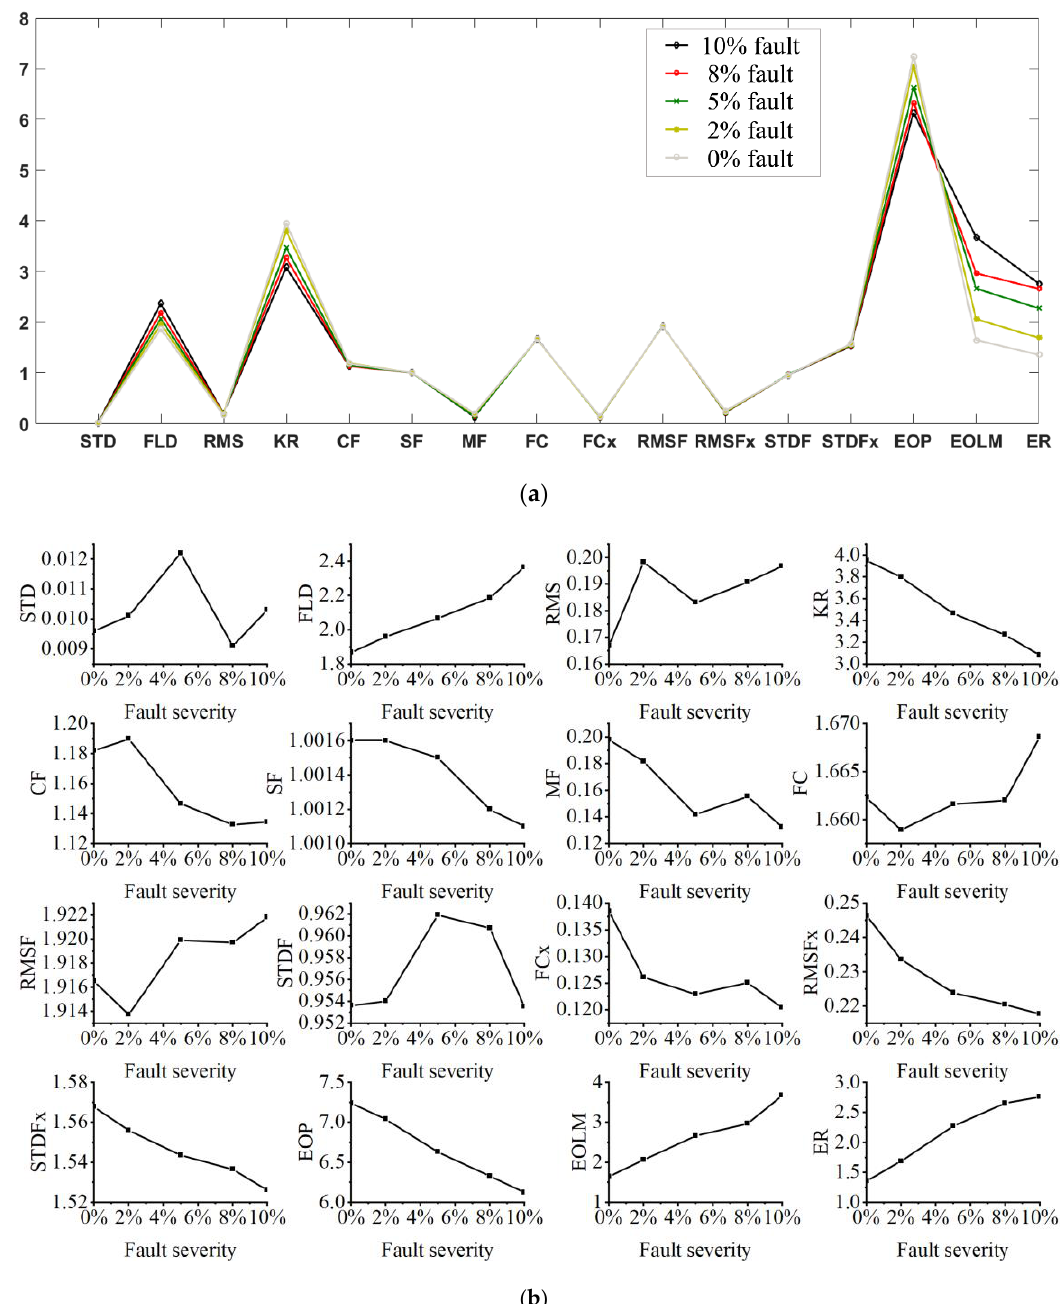
Figure 6. Results of fault feature extraction of the surge velocity signal for weak fault severity: ( a ) Feature comparison; ( b ) All feature values.